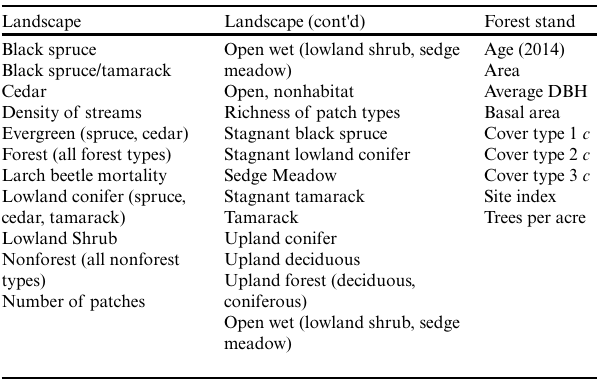
Table 1 . Landscape and forest stand variables included in habitat modeling. Landscape variables were summarized in 200, 500, and 1000 m buffers surrounding all 30 m grid cells in the